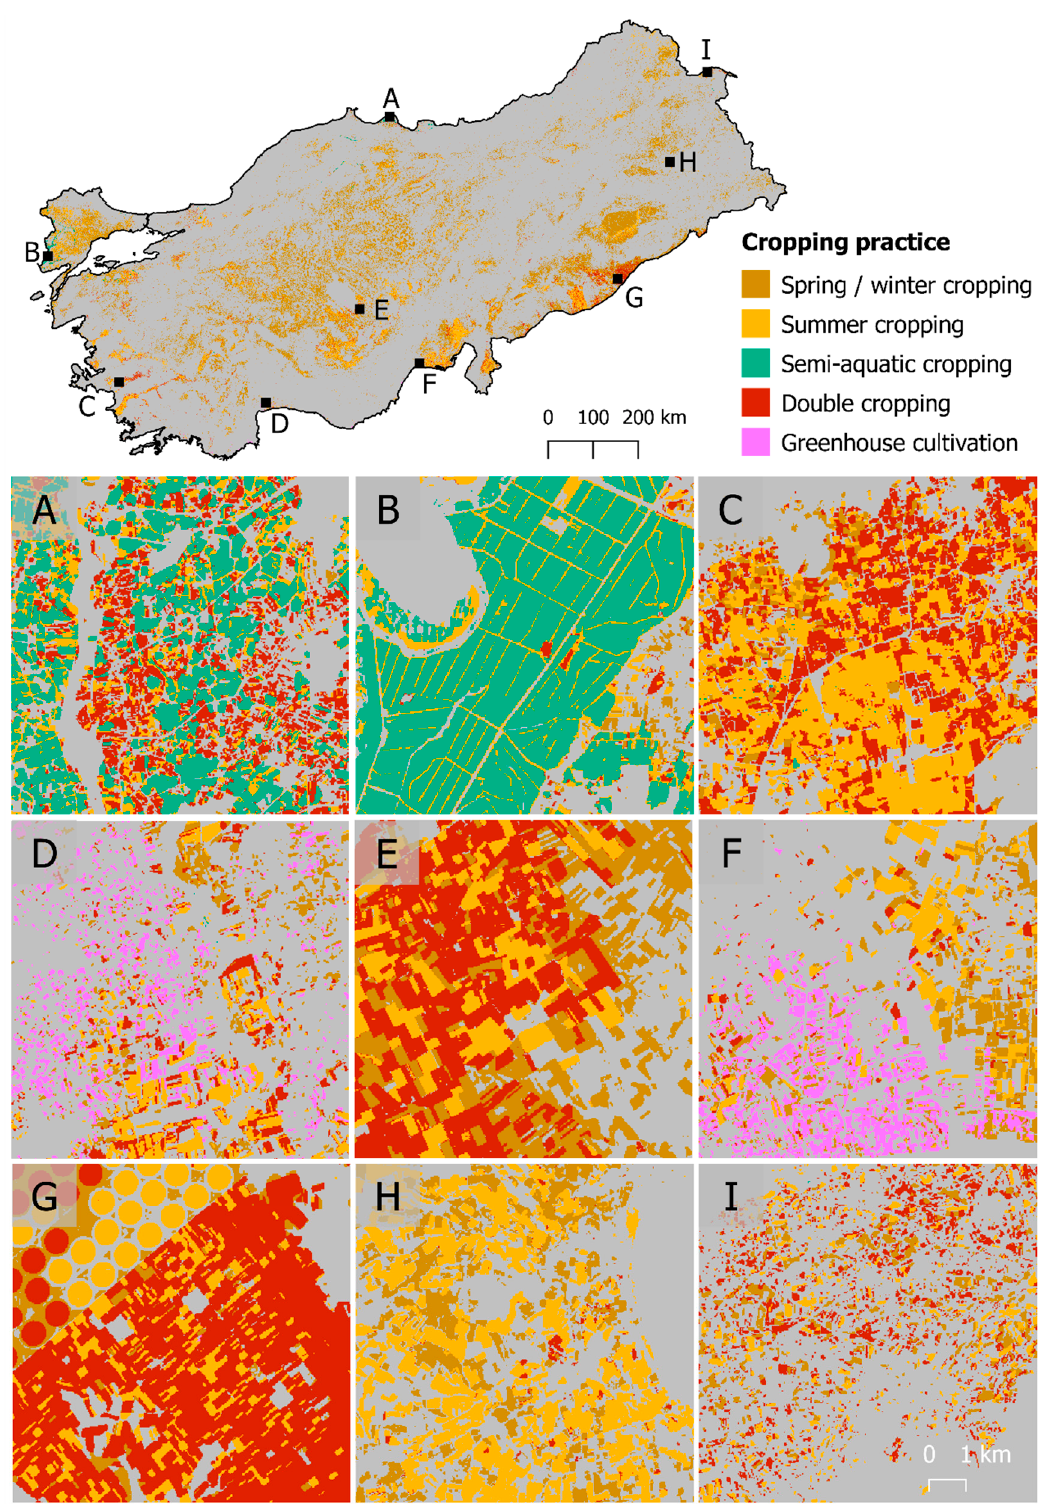
Figure 7. National-scale cropping practice map for the year 2015 (upper section), based on eight-day time-series of Tasseled Cap Brightness, Greenness, and Wetness including four annual statistics (WKL_TC_STATS). Black rectangles indicate location of subsets A to I (lower section).